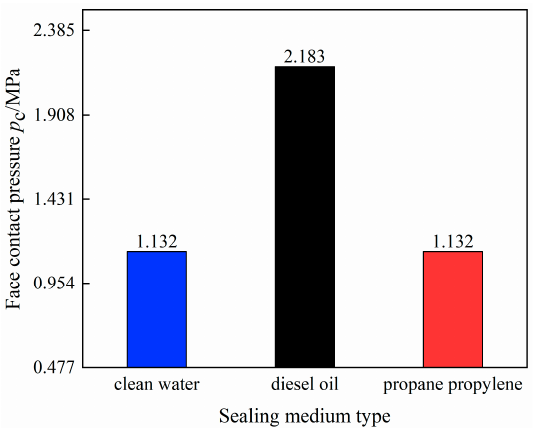
Figure 4. The face contact pressure range of different sealing media.